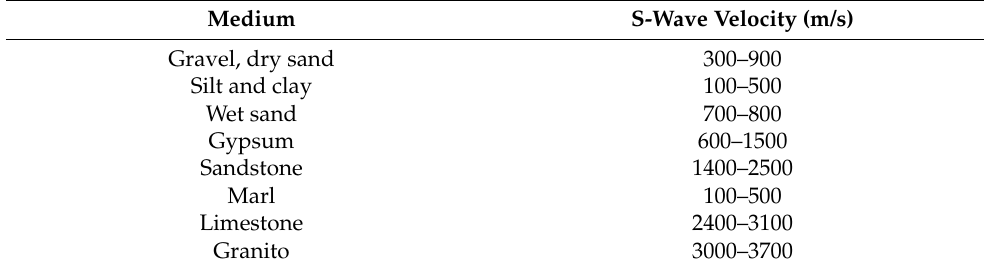
Table 1. The propagation velocities of seismic waves through different types of geological media (from Tendürüs et al., 2015 [46] and Earle, 2019